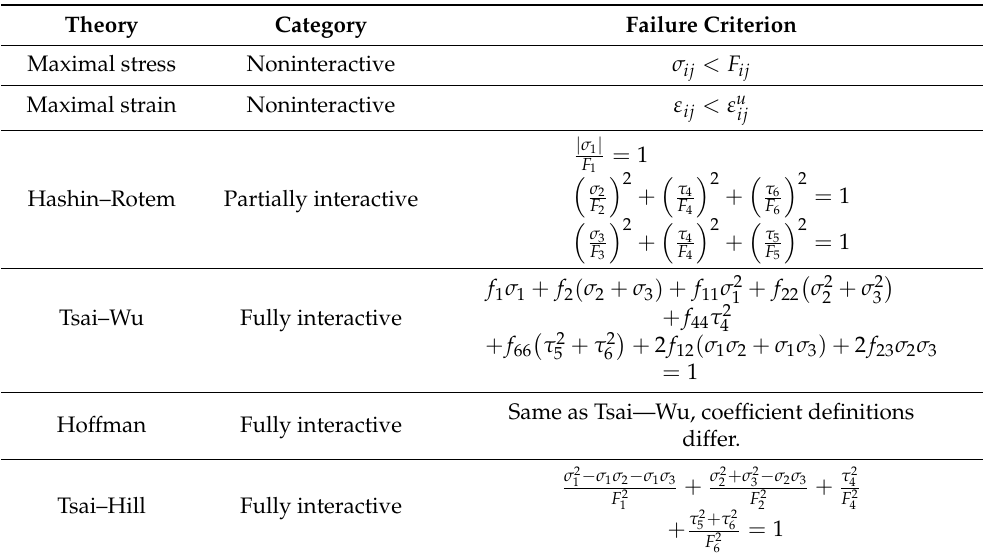
Table 3. Failure criteria chosen for analysis in this work